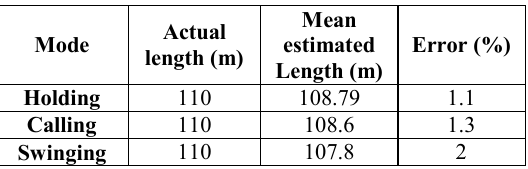
Table 6. Results of the estimated path length algorithm